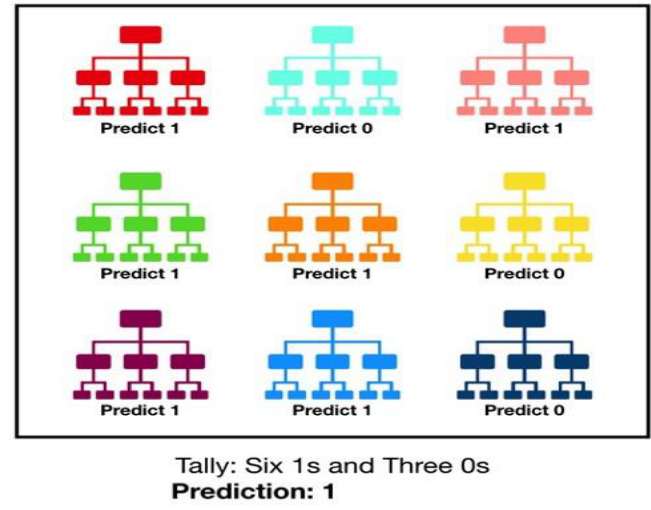
Figure 5. RF classifier [25] .